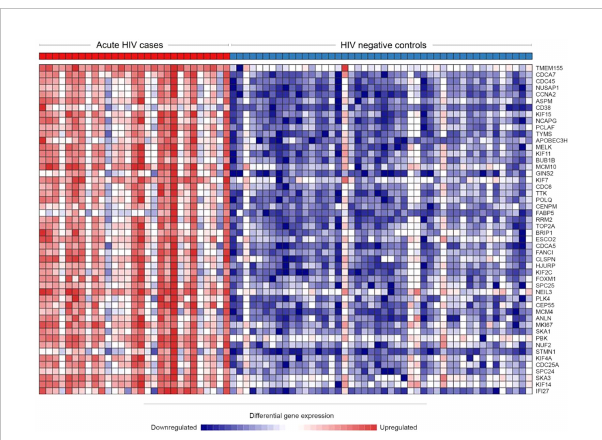
FIGURE 2 Heatmap of the top 50 most upregulated genes during HIV infection, demonstrating high consistency between individuals. Network Analyst was used to view a heatmap of the raw expression counts for each acutely infected (n=29) and HIV negative (n=46) individual. The top 50 most signi fi cantly DEGs were all upregulated during acute